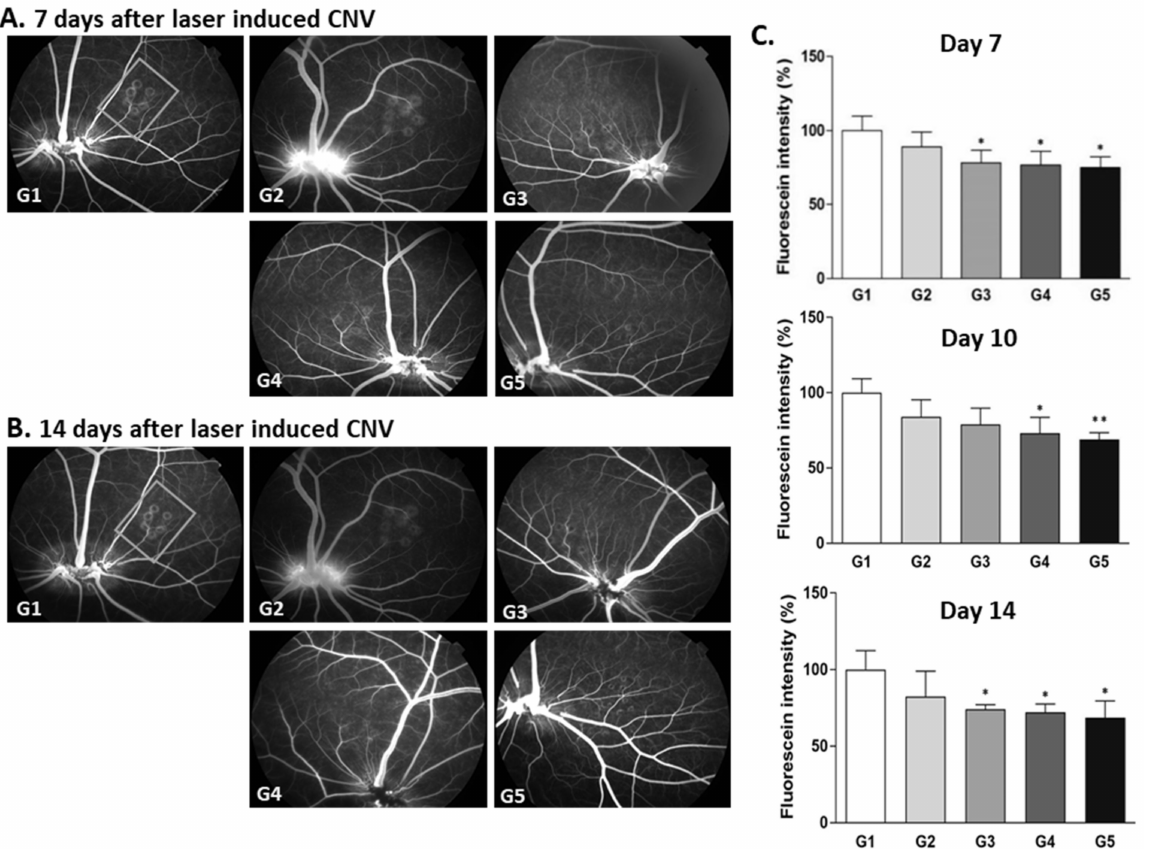
Figure 5. The effects of the intravitreal administration of Ac-RLYE and ranibizumab on inhibition of choroidal neovascu- larization (CNV) in laser-induced CNV minipig models with treatment peptide or ranibizumab at the same day as laser irradiation. The intensity of laser irradiation and spot size was empirically set to maintain the retinal fluorescence intensity in the vehicle treatment group at 2 weeks after laser irradiation. ( A , B ): Representative retinal fluorescence fundus image. ( C ): A quantitative image analysis result for retinal fluorescence intensity using the ImageJ software. The day of laser irradiation was designated as day 0. Data are expressed as mean ± S.D. G1: Vehicle control, G2: Ac-RLYE 1 µ g/50 µ L/eye, G3: Ac-RLYE 3 µ g/50 µ L/eye, G4: Ac-RLYE 10 µ g/50 µ L/eye, G5: Ranibizumab 500 µ g/50 µ L/eye (Both eyes of 2 minipigs per group were administrated). **/* A significant difference at p < 0.01/ p < 0.05 level compared to the G1. Compared to vehicle group (arbitrarily set at 100%, G1), the retinal fluorescence intensity in the Ac-RLYE groups was significantly decreased in a dose-dependent manner